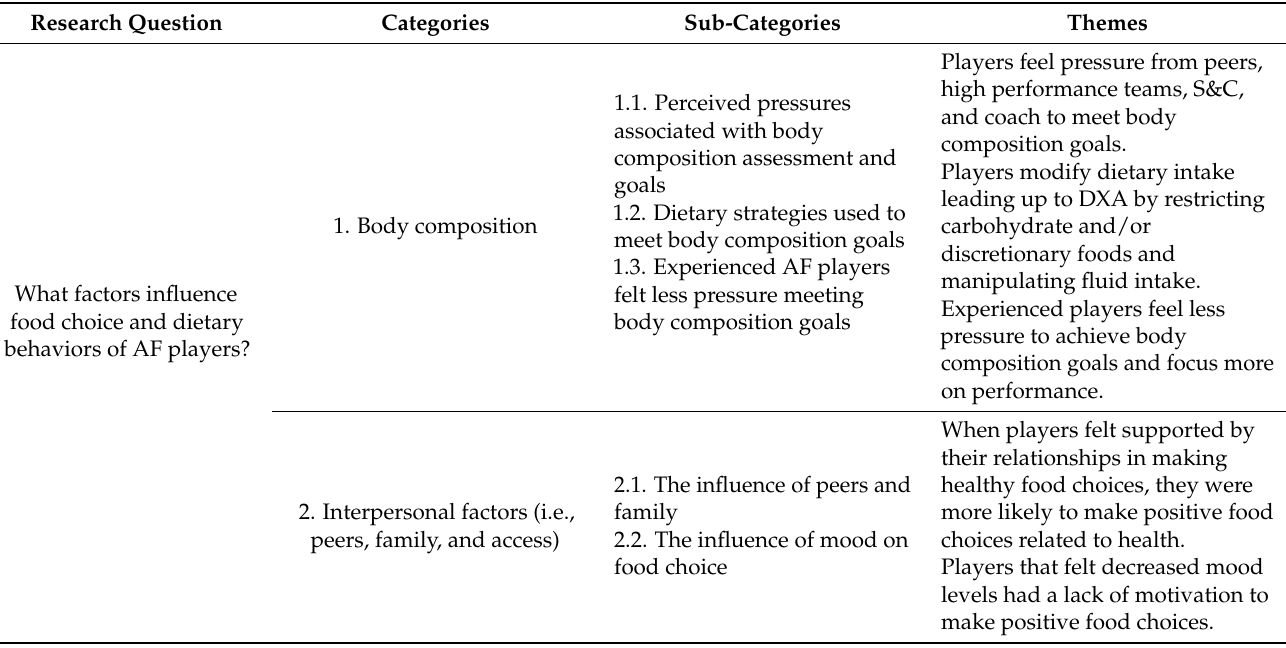
Figure 1. Factors that influence Australian football players’ personal food choice. Table 2. A summary of categories, sub-categories and themes identified from semi-structured